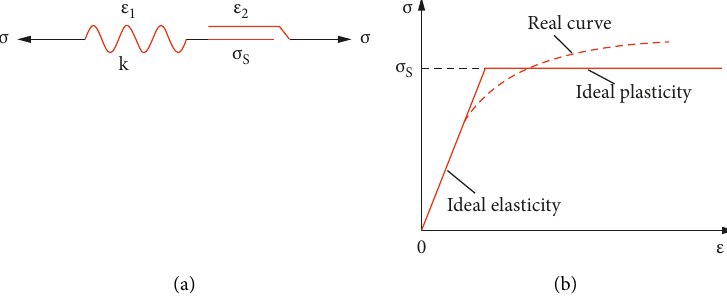
Figure 2: Schematic diagram of the constitutive relationship of Saint-Venant body. (a) Saint-Venant body mechanical model, (b) schematic diagram of elastoplastic